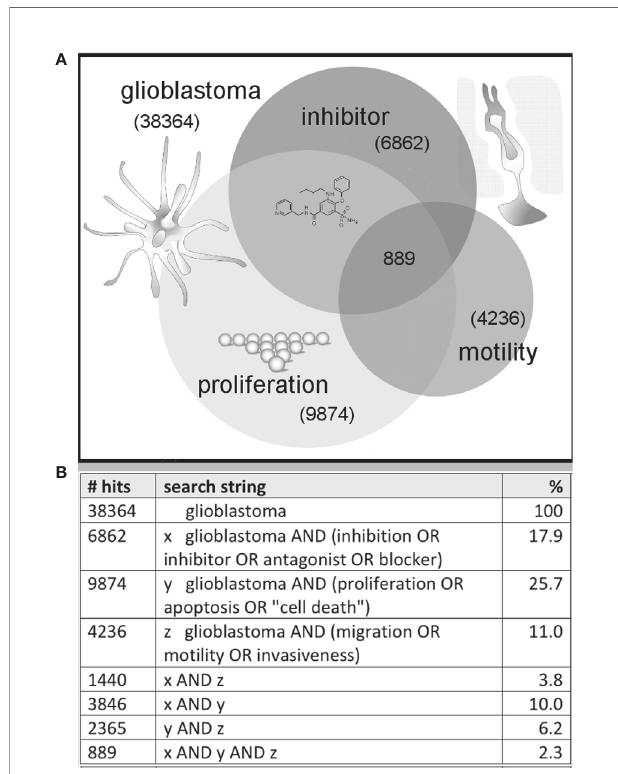
FIGURE 1 | Illustration of a sample distribution of published glioblastoma studies suggesting less than 3% combine three themes (inhibitor, proliferation, motility). Venn diagram (A) summarizing the numbers of published articles on glioblastoma, with key words linked to inhibition, migration and growth, as of November 2019 based on a search of the NIH PubMed database, with search strings as de fi ned in the table (B)